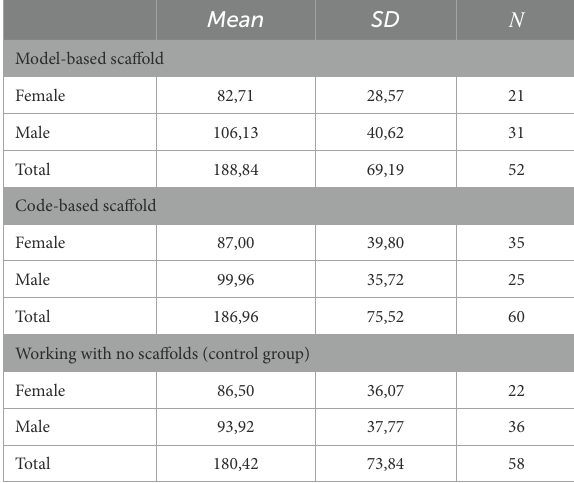
between-subject effects for type of scaffold, F (2, 164) = 11.03, p < 0.01, in favor of the model-based scaffolding in Phase 2, and gender, F (1, 164) = 10.63, p < 0.01, in favor of boys who performed at their best in Phase 3.